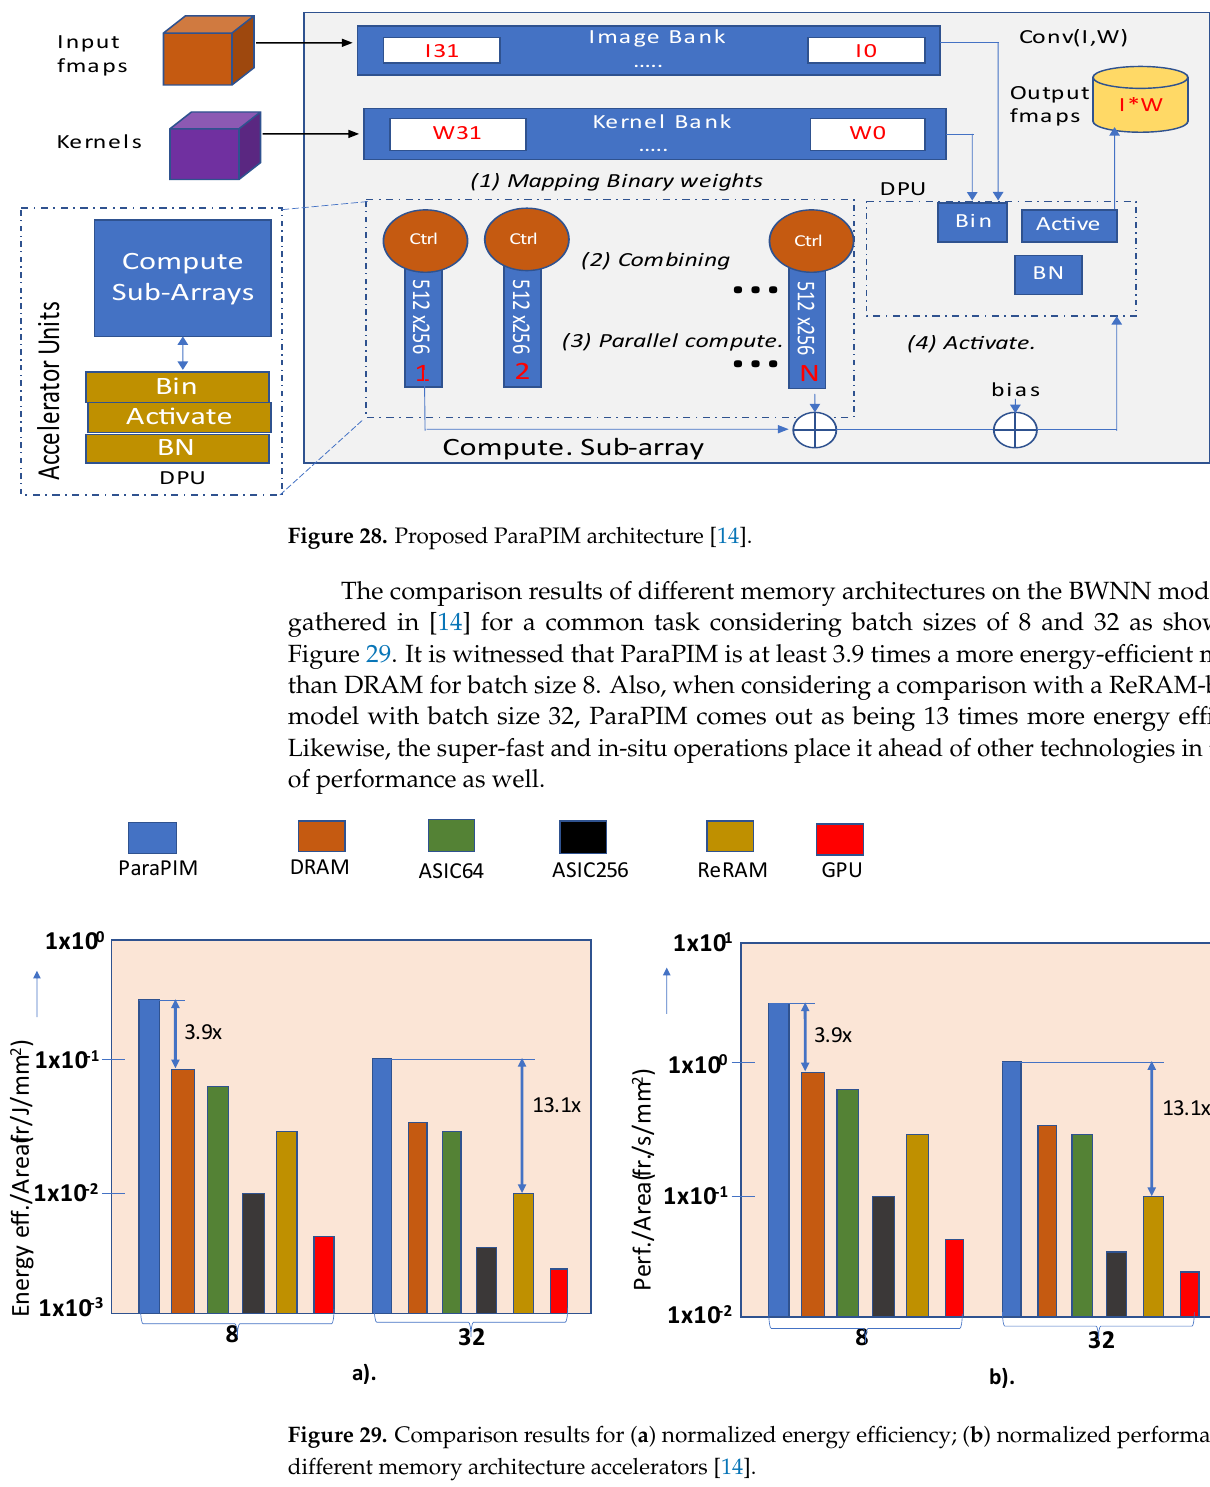
Figure 29. Comparison results for ( a ) normalized energy efficiency;( b ) normalized performance of different memory architecture accelerators [14].